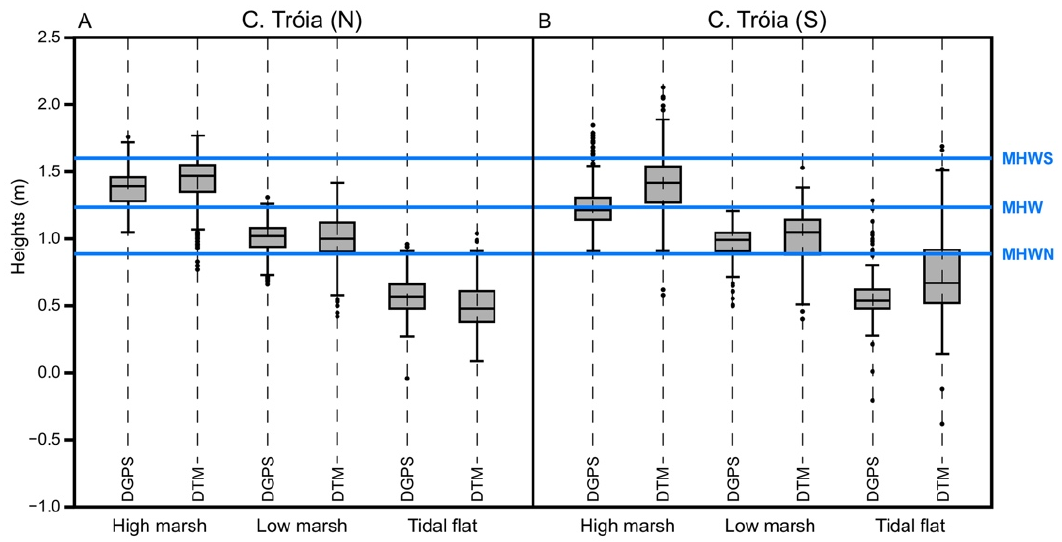
Figure 3. Boxplots showing the distribution of heights obtained through DGPS and DTM. ( A ) C. Tróia (N); ( B ) C. Tróia (S). Blue lines indicate the heights of local critical tidal levels: MHWS—mean high water spring; MHW—mean high water; MHWN—mean high water neap.